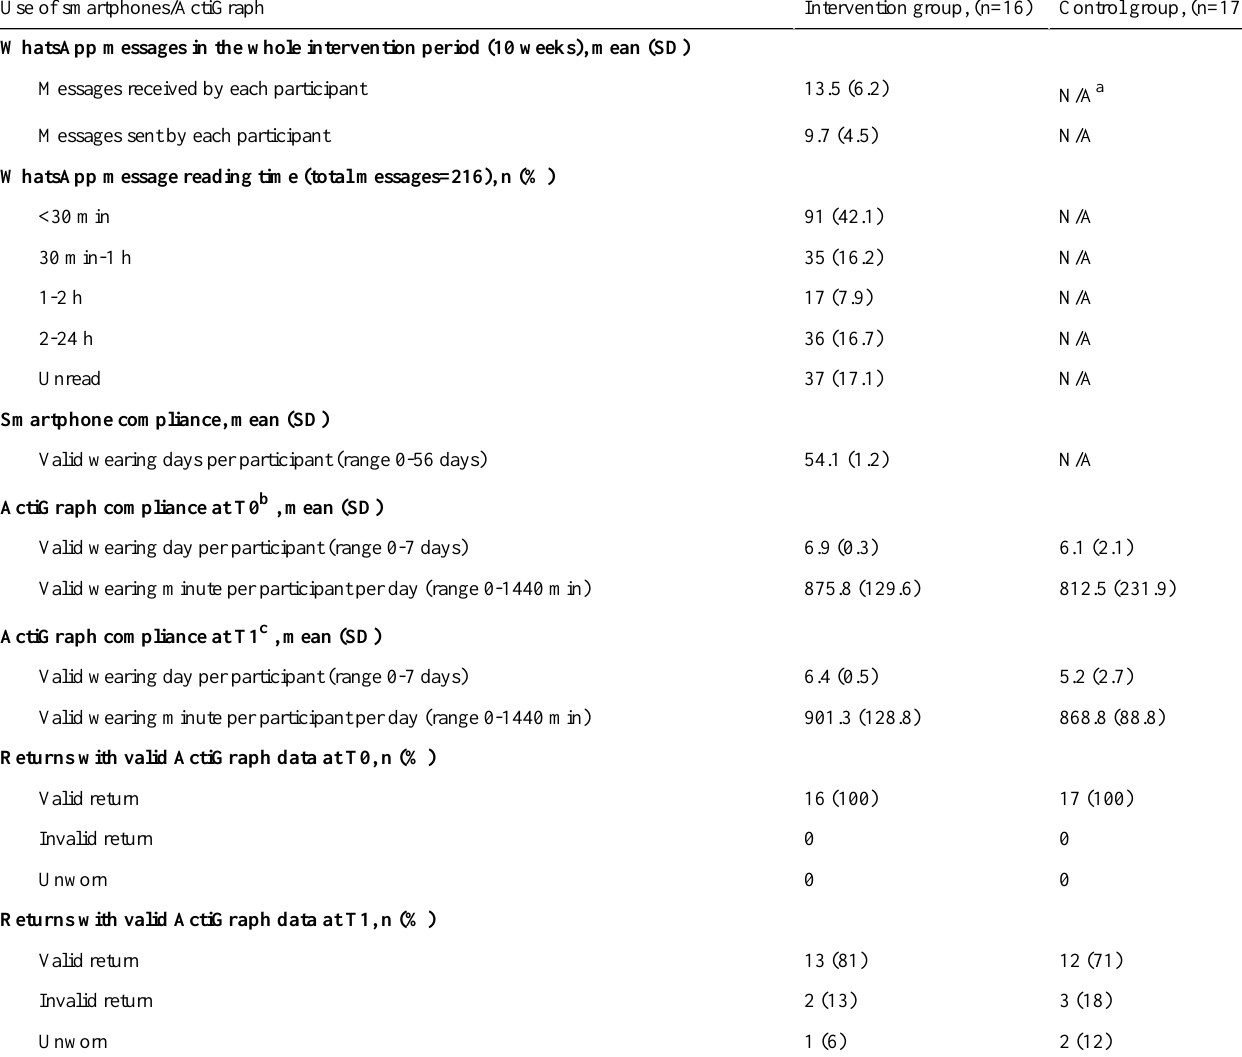
Table 6. Smartphone and ActiGraph use and